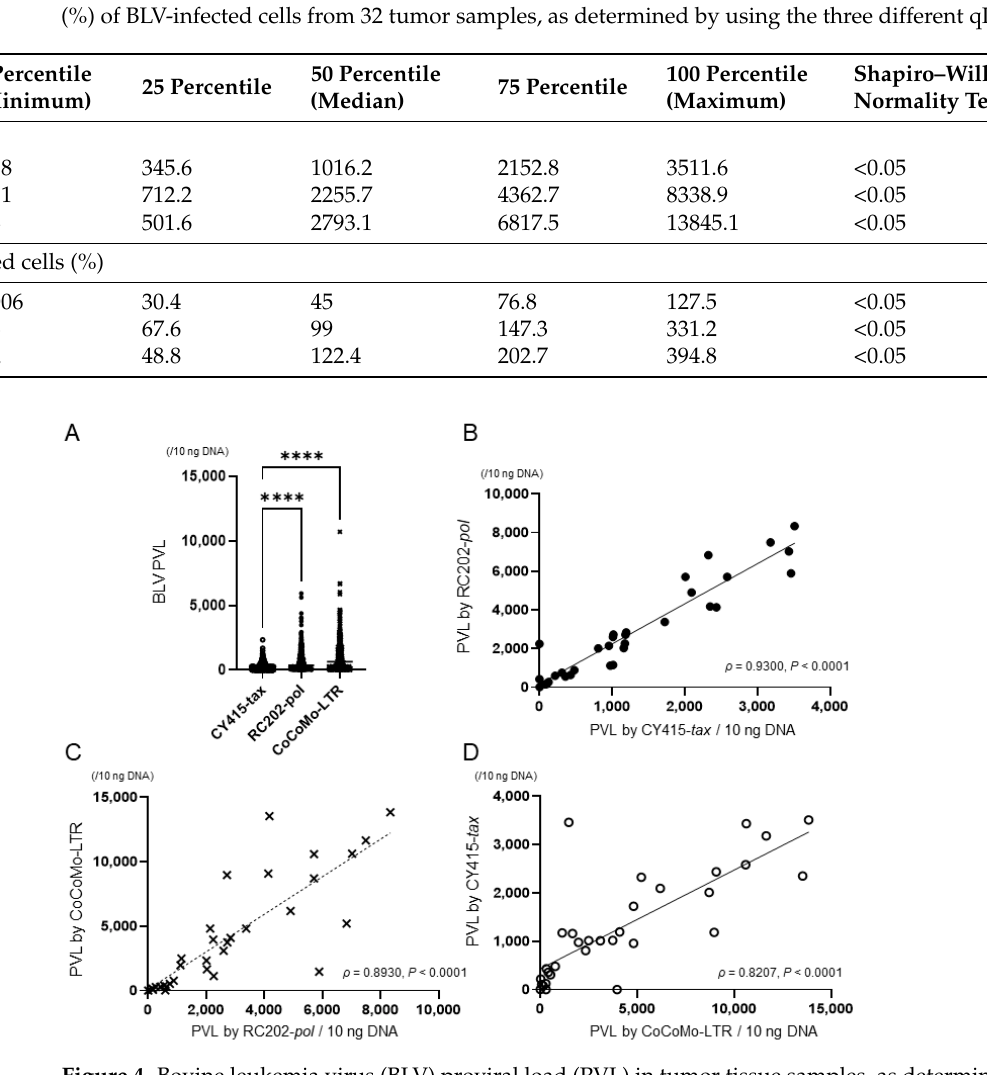
Figure 4. Bovine leukemia virus (BLV) proviral load (PVL) in tumor tissue samples, as determined by different qPCRs. ( A ) BLV PVL. Differences between values obtained were assessed by using Kruskal–Wallis tests with Bonferroni’s multiple comparison as an ad hoc test. Horizontal bars indicate median values. ****, p < 0.0001. ( B – D ) Correlations between PVLs determined by each qPCR. Spearman’s correlation coefficient ( ρ ) and levels of significance (P) regarding values are indicated in the graphs. Diagonal lines are regression lines.